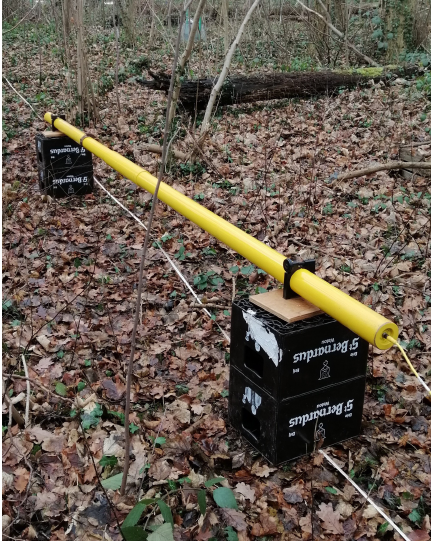
Figure 5. Multi-receiver FDEM measurement using a multi-receiver instrument at 0.6 m height; transmitter and receiver coils are arranged as sketched in Figure 1 with an additional HCP/PRP coil pair at 4 m/4.1 m,